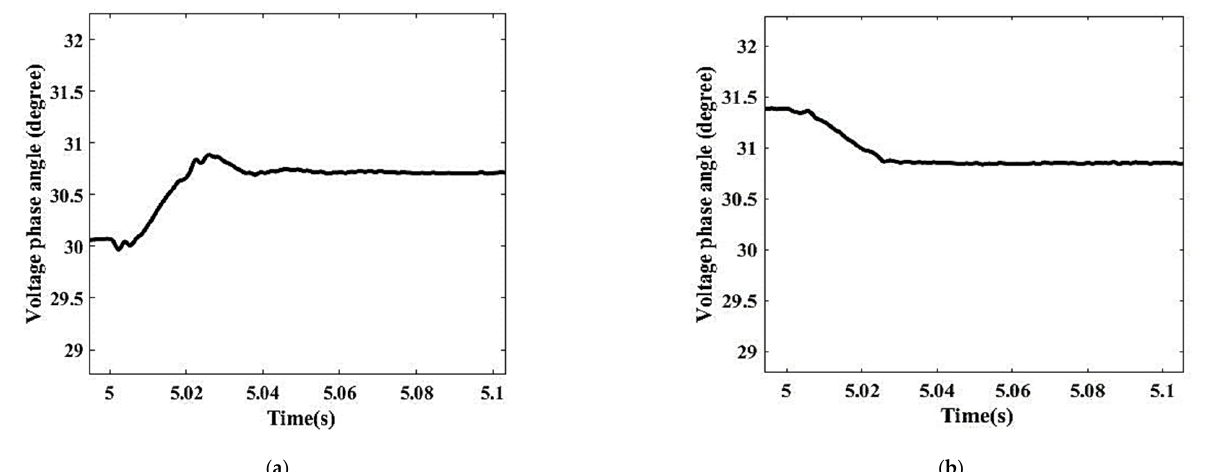
Figure 10. Magnitude of voltage phase angle during motor operation ( a ) Starting of induction motor ( b ) Unloading of induction motor.